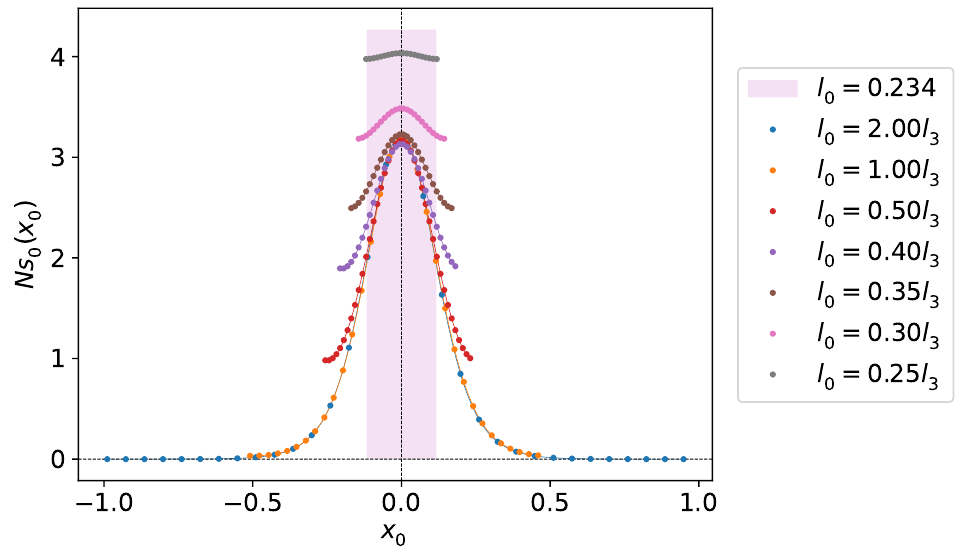
Figure 7. Solutions obtained for our spatial torus geometry and various values of the time extent l 0 changing from the Fibonacci constant curvature case ( l 0 = 0 . 234 l ) represented by the pink box, to the case l = 2 l 0